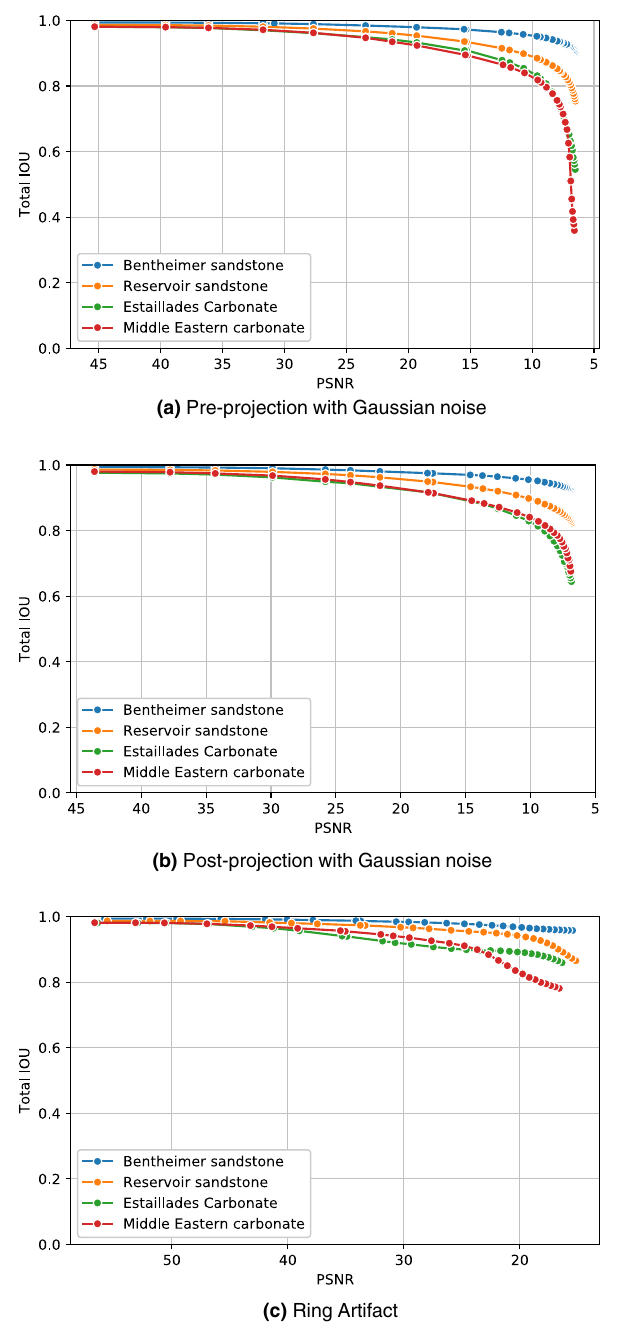
Figure 9. Segmentation sensitivity to different levels of Gaussian noise and ring artifact for four different